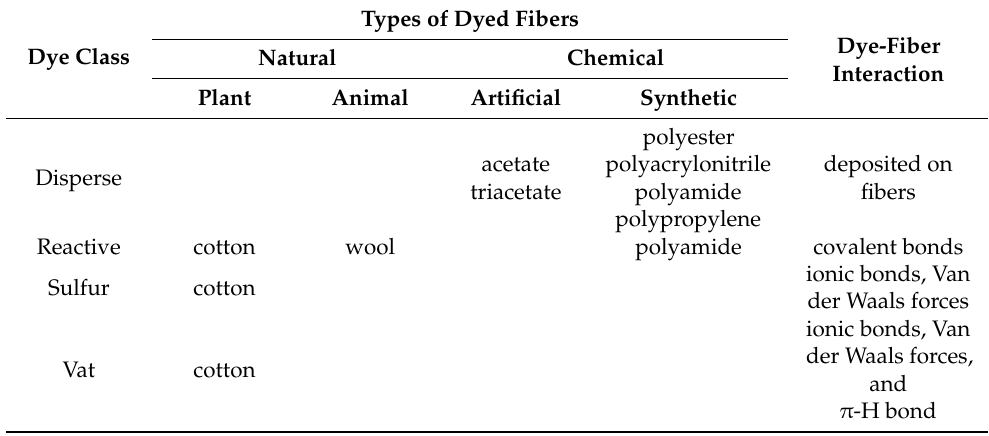
Table 1. Cont . Types of Dyed Fibers Dye-Fiber Dye Class InteractionNatural Chemical Plant Animal Artificial Synthetic polyester deposited on polyacrylonitrile acetate Disperse fibers polyamide triacetate polypropylene Reactive cotton wool polyamide covalent bonds ionic bonds, Van Sulfur cotton der Waals forces ionic bonds, Van der Waals Vat cotton